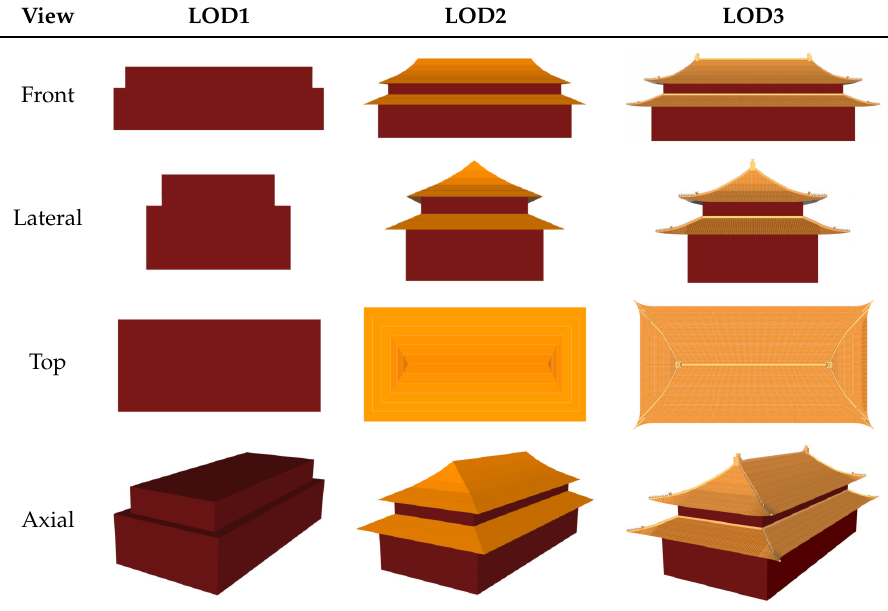
Table 3. Ancient Chinese-style architectural roof models in LOD1, LOD2 and